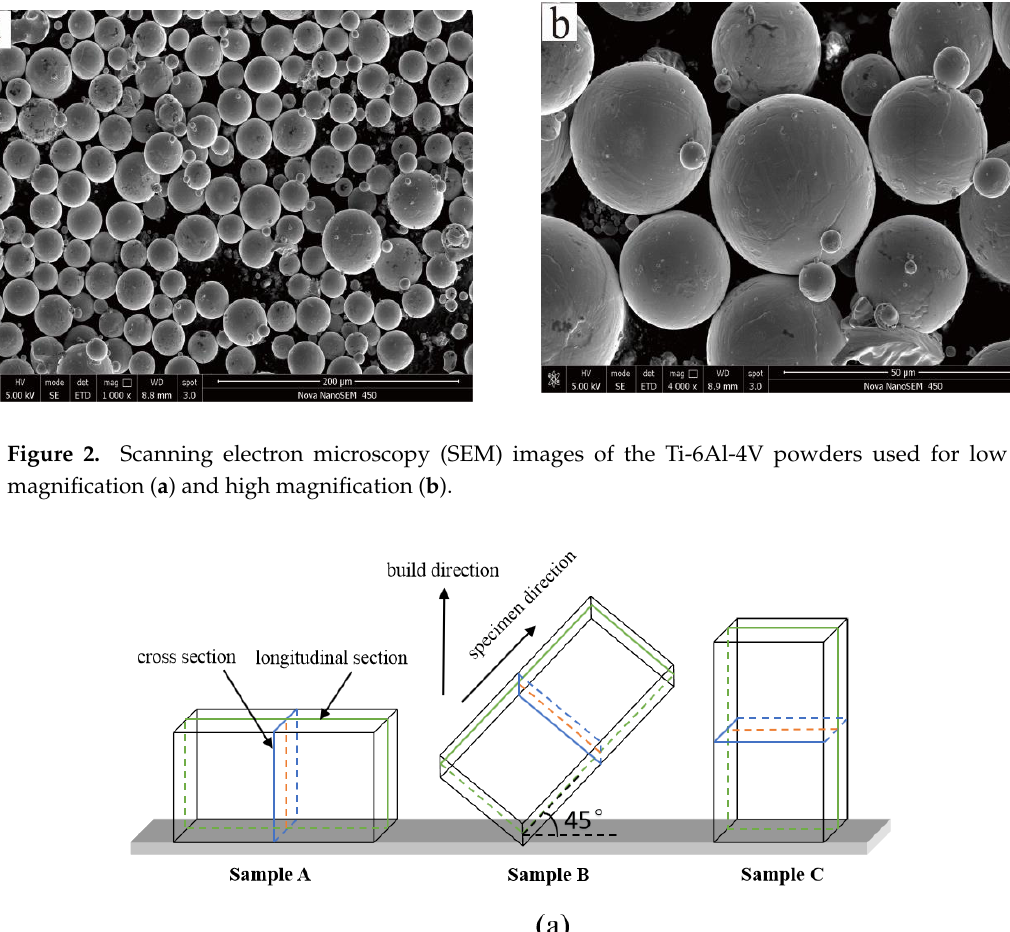
Figure 2. Scanning electron microscopy (SEM) images of the Ti-6Al-4V powders used for low magnification ( a ) and high magnification ( b ). Table 1. Chemical composition of the Ti-6Al-4V alloy powder